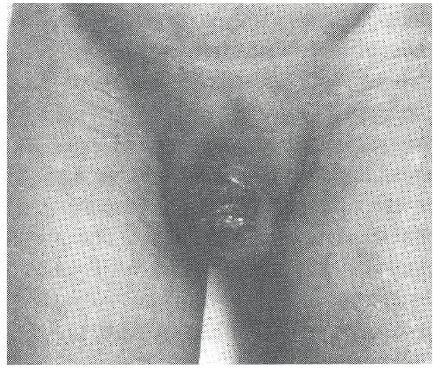
Figure 2: Showing tuberculous ulcer of glans penis. Reproduced from [5] D. K. Pal, A. K. Kundu, S. Chakraborty, S. Das,